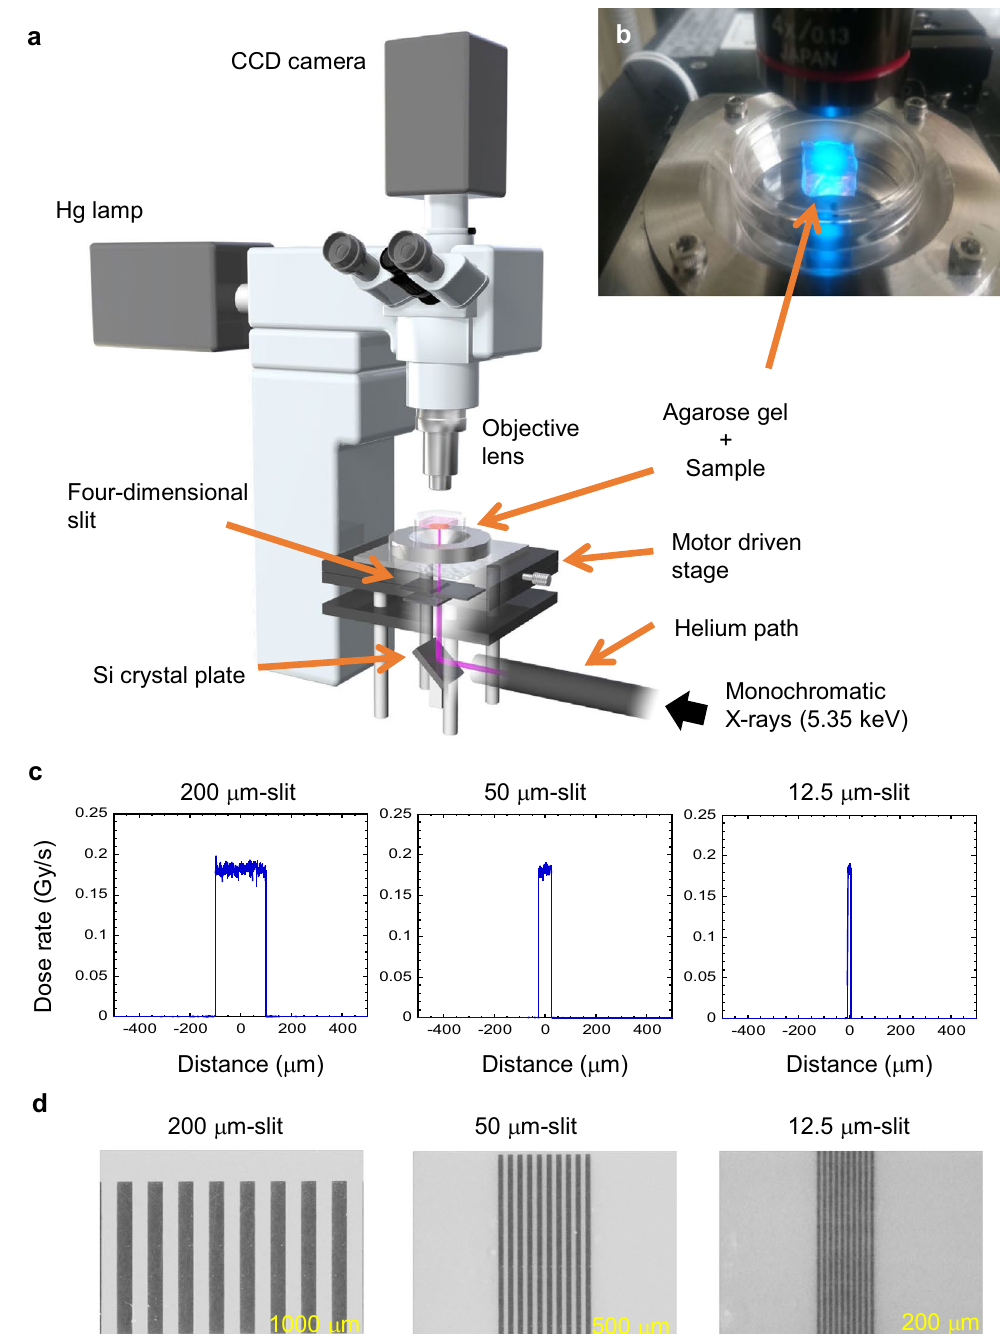
Figure 2. Synchrotron-generated X-ray microbeam irradiation settings. ( a ) Optical apparatus for X-ray microbeam irradiation, using the synchrotron beamline BL-27 at the Photon Factory, High Energy Accelerator Research Organization (KEK). ( b ) Photo of X-ray microbeam irradiation settings with ex vivo testes organ cultures. ( c ) Dose profiles of the 200, 50, and 12.5 μ m-width microbeams, calculated with PHITS code. The beam intensity was essentially flat within the beam width. The deviation of the dose was about ± 6% of the averaged dose. Due to the very short range of secondary electrons (1.1 μ m maximum) produced by the 5.35 keV X-ray exposure, the doses delivered outside of the irradiated area was negligible ( < 0.25%). ( d ) Dose profiles of the 200, 50, and 12.5 μ m-width microbeams were also confirmed using Gafchromic XR-RV3 radiochromic film (Ashland Inc., Covington, KY, USA). Scale bars, 1000, 500, and 200 μ